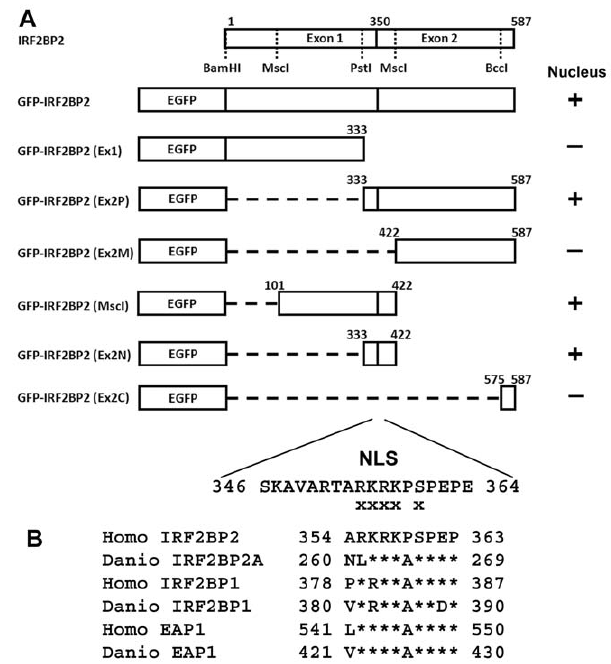
Figure 6. Identification of the phosphorylation-dependent NLS of IRF2BP2. A. Diagram of deletion and mutagenesis constructs used to identify the phosphorylation-dependent NLS. Fusion proteins that are targeted to the nucleus are identified by a + , whereas those that are cytoplasmic are identified by -. Exes (x) represent mutagenized residues that abolish nuclear localization. B. Sequence conservation of the NLS. In all 3 paralogous genes, IRF2BP2, IRF2BP1 and EAP1 in humans (Homo sapiens) and zebrafish (Danio rerio), the NLS and the phosphorylation target sequences are conserved. Asterisks represent identical sequence.